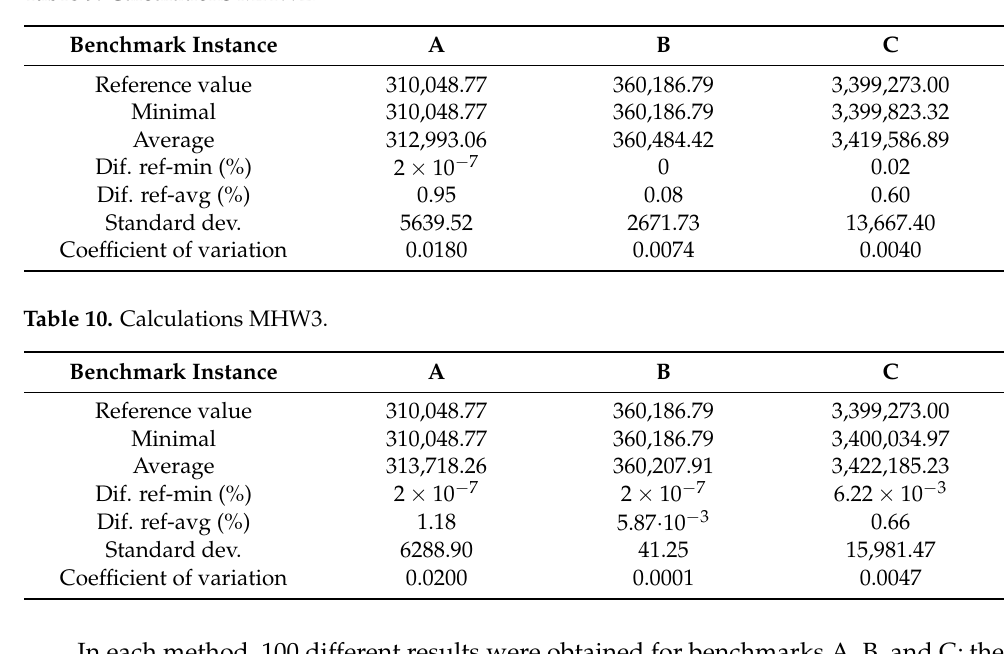
Table 9. Calculations MHW2.